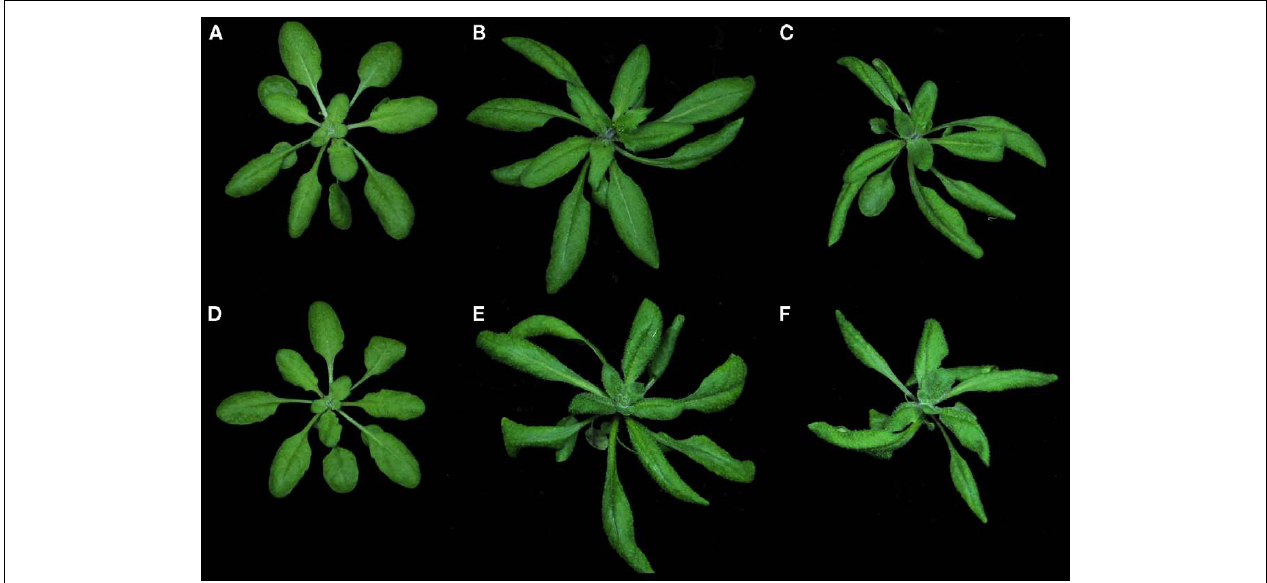
FIGURE 1 |Vegetative phenotypes in response to environmental conditions (A–F). Phenotype of wild-type (A–C) and pan mutant (D–F) plants grown under short-day [SD (A,D) ], long-day [LD (B,E) ], and continuous light [CL (C,F) ] conditions for 21days. Note leaf-curling, elongated petioles and twisted leaf rosettes under LD and CL